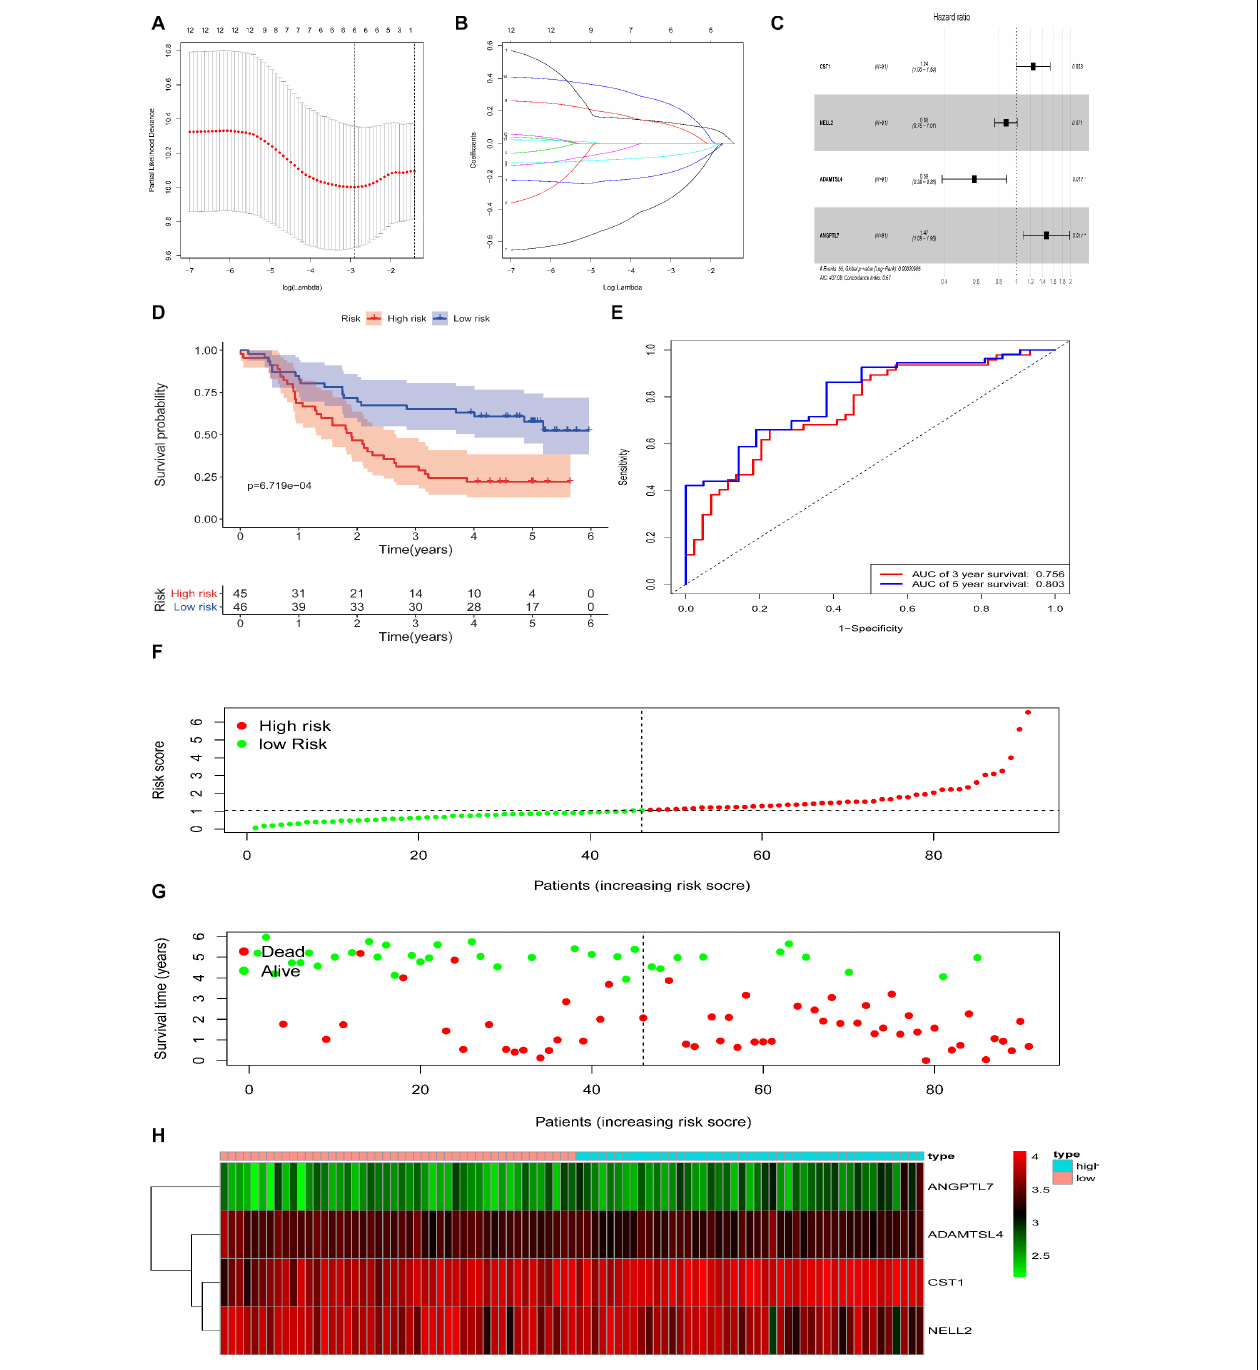
FIGURE 3 | Construction of the DEG-based prognostic signature in the training cohort of patients with ESCC. (A,B) Lasso analysis yielded six genes for further analysis. (C) Multivariate regression analysis identified four genes to be included in the ECM-related prediction model. (D) Kaplan-Meier survival curves of the relative overall survival of the high- and low-risk groups. (E) ROC curve analysis of the prognostic signature. (F) Distribution of the four gene-based risk scores. (G) Vital statuses of patients in the high- and low-risk groups. (H) Heatmap of four-gene expression profiles in the high- and low-risk groups.